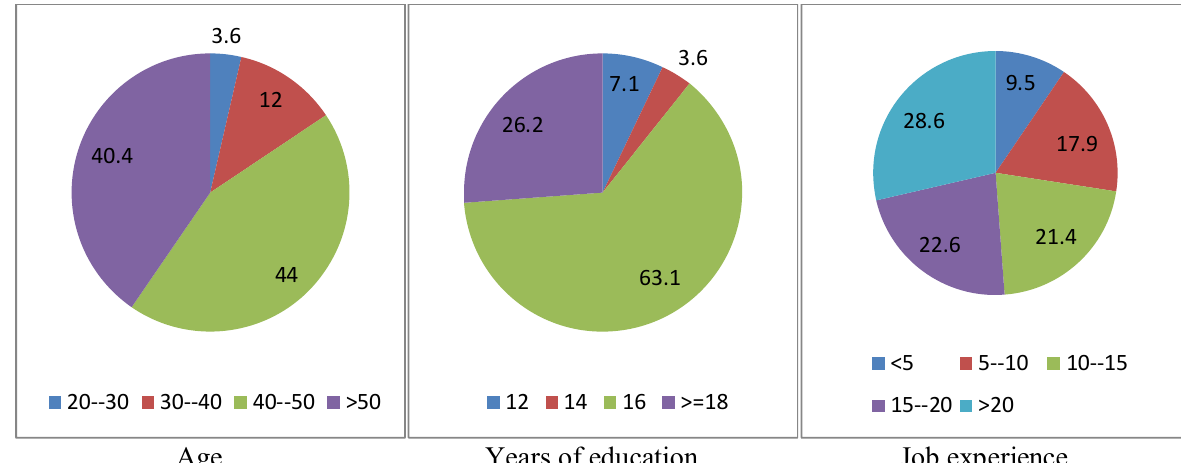
Fig. 1. Personal characteristics of the participants